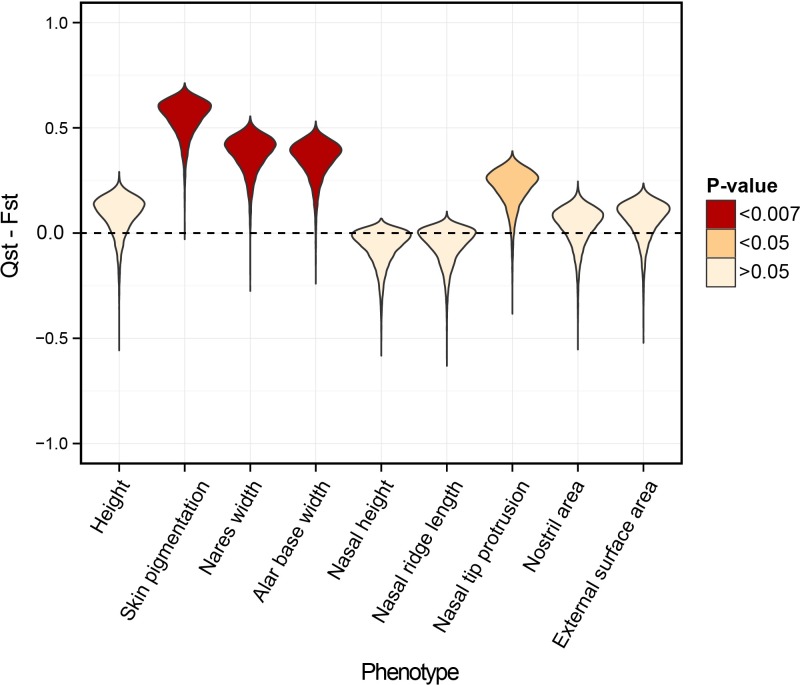
Qst–Fst results across all populations.The bootstrapped distribution of Qst–Fst for each phenotype (shown by a violin plot) is compared against the expected value of zero under neutrality (horizontal dashed line). Phenotypes, which exhibit accelerated divergence (using a Bonferronni corrected p-value threshold of 0.0071), are shown in red.